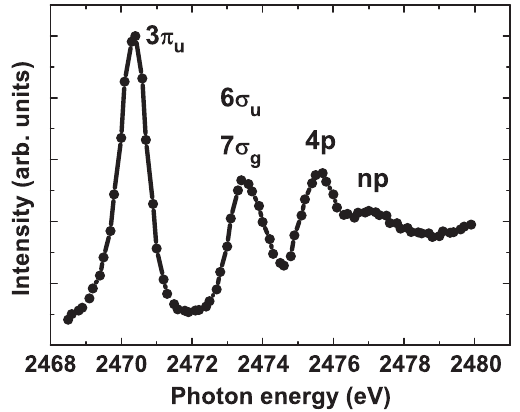
FIG. 1. Experimental partial x-ray fluorescence yield of the sulfur K hole in the CS 2 molecule, constructed by integration of the S K β emission spectrum over the 2445 – 2485 eVenergy range, at fixed incidence photon energy. The emission spectra are recorded at the scattering angle θ ¼ π = 2 , in the direction of the incident polarization. The absorption resonances are assigned according to [27] as transitions from the S 1s shell to the